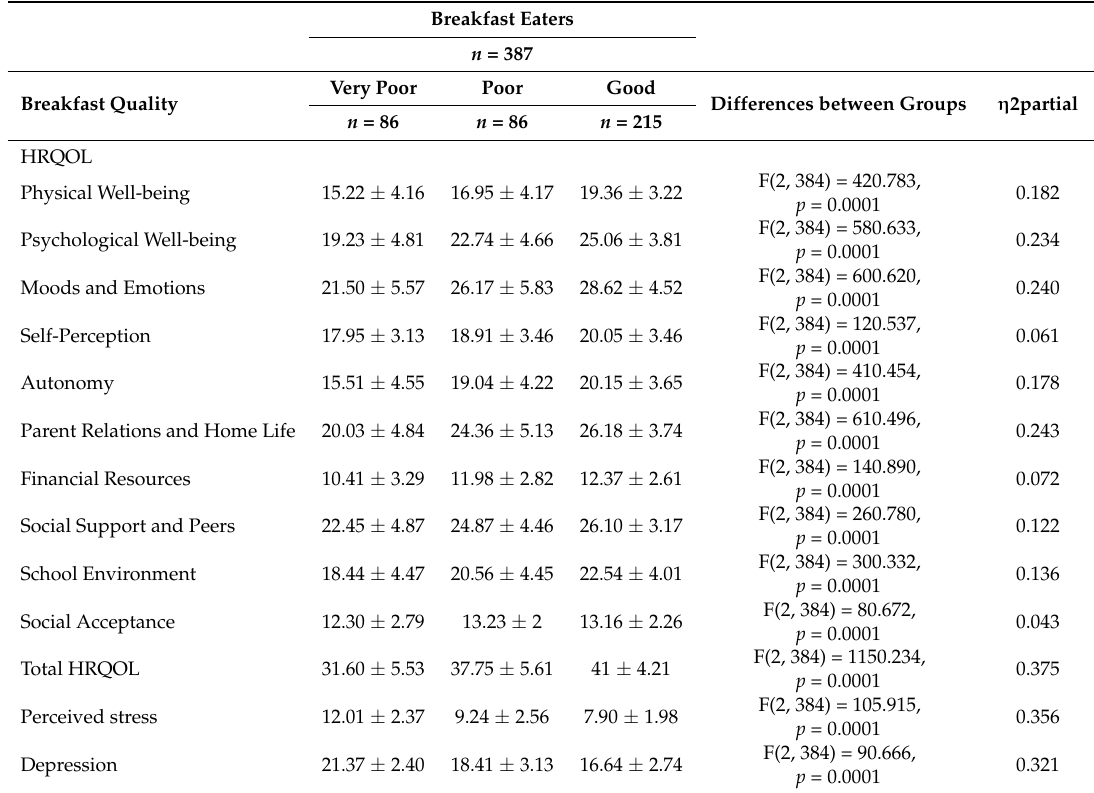
Table 2. Differences in HRQOL, perceived stress and depression between breakfast eaters depending on breakfast